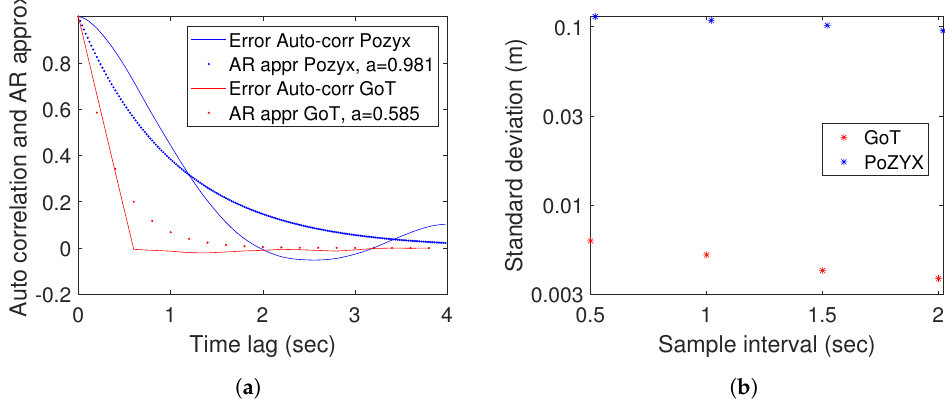
Figure 11. ( a ) Auto-correlation of X-coordinate for Pozyx and GoT along with AR-approximations. ( b ) Standard deviation after short term averaging (vertical axis is log